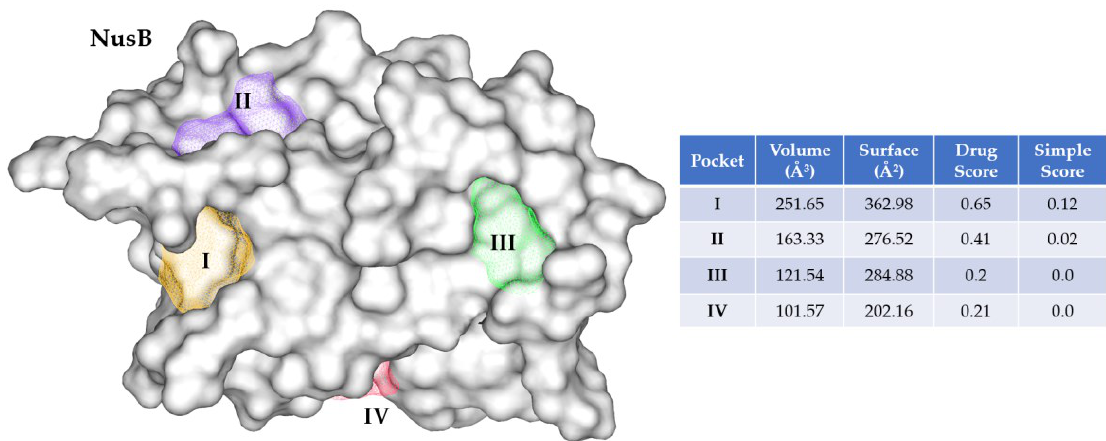
Figure 8. Binding pockets of NusB (PDB: 3D3B, [17]) calculated by Protein Plus.